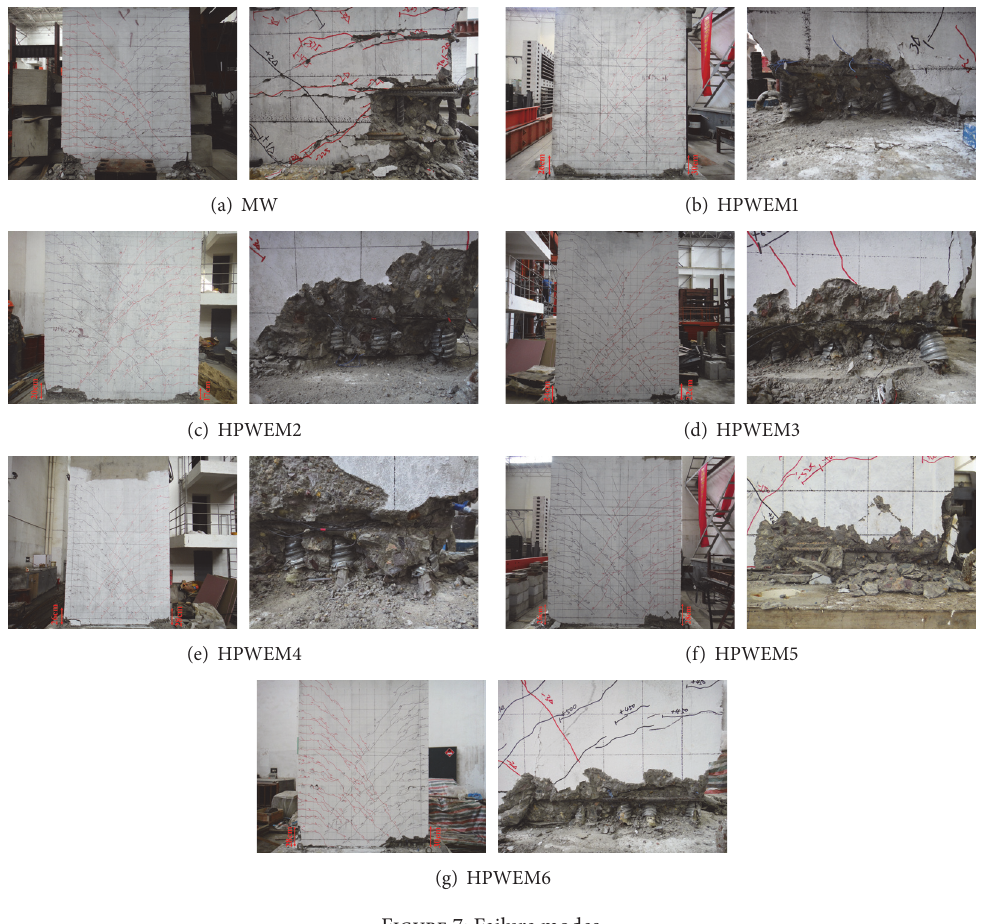
Figure 7: Failure modes.